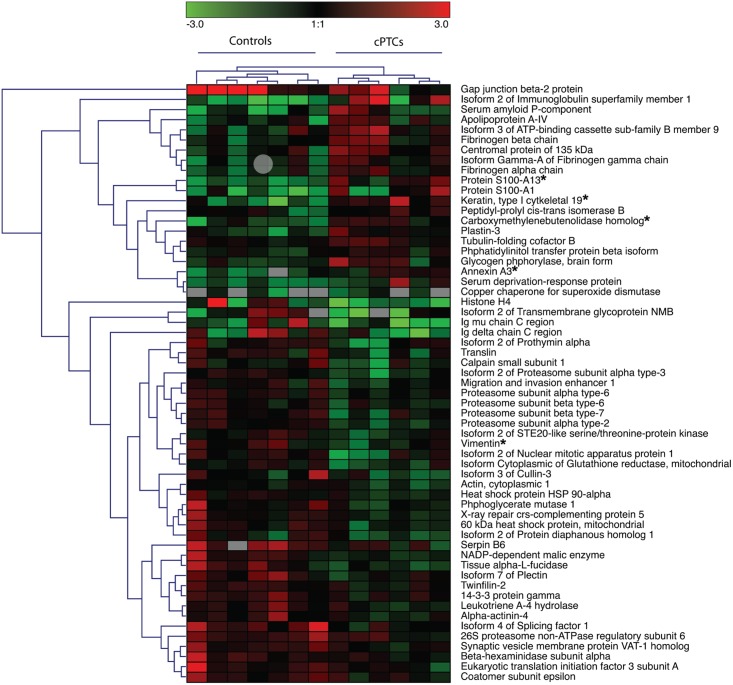
Unsupervised hierarchical clustering showing the 59 proteins in the OPLS model.Up-regulation and down-regulation of proteins in cPTC vs. benign lesions are indicated in red and green, respectively. Proteins selected for further verification are indicated by (*).